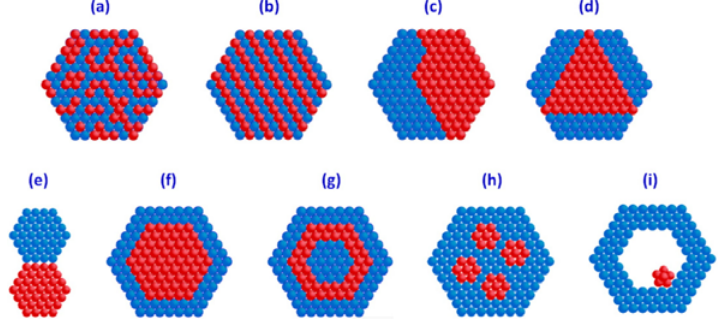
Figure 1. Structures of bimetallic nanoparticles: ( a ) mixed alloys; ( b ) alloys; ( c ) subclusters with two interfaces; ( d ) subclusters with three interfaces; ( e ) subclusters with a small number of A–B bonds; ( f ) core ‐ shell nanoparticles; ( g ) multishell core ‐ shell nanoparticles; ( h ) multiple small core material coated by single shell material, ( i ) movable core within hollow shell material. Reprinted with